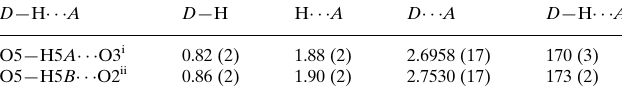
Hydrogen-bond geometry (A˚ , (cid:3) ).